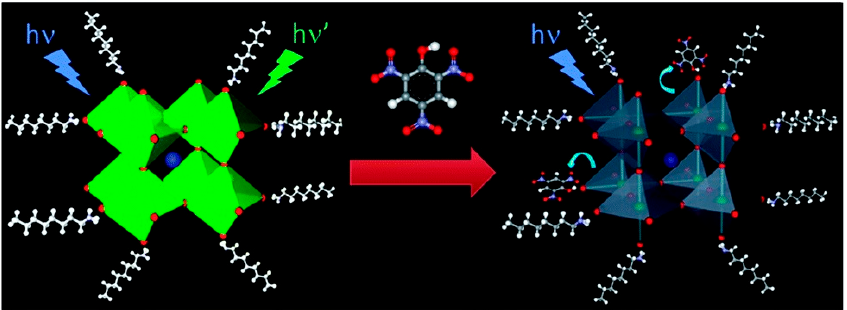
Figure 13. Schematic illustration for the sensitive fluorescence detection of PA based on perovskite quantum dots (reproduced with the permission from reference [144]).